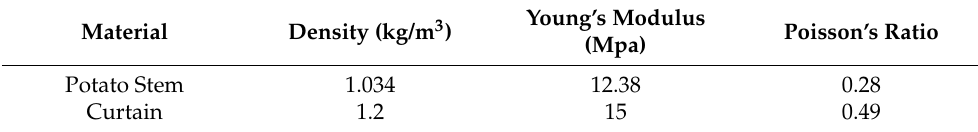
Table 2. Potato stem and curtain material parameters.